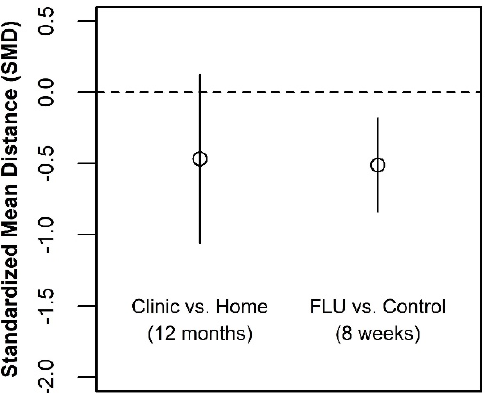
Figure 8. Estimated effect on depression of test venue compared with fluoxetine treatment